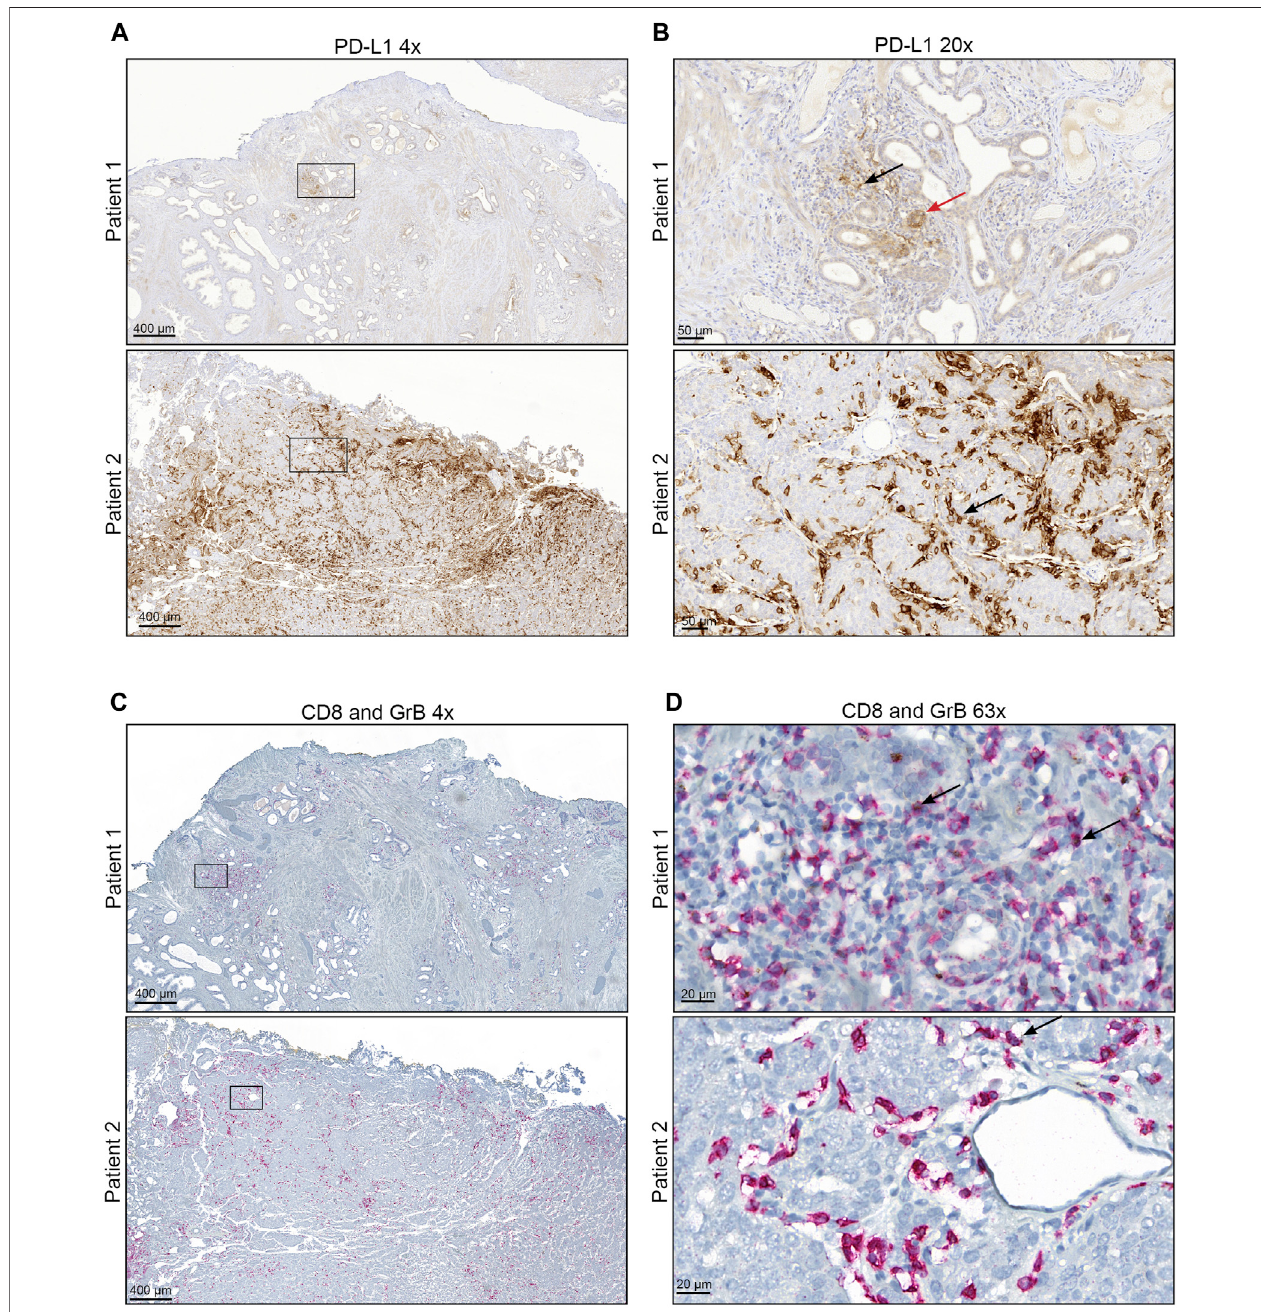
FIGURE 1 | Representative staining of PD-L1, CD8 + , and GrB (A + B) Immunohistochemical staining for PD-L1 of representative PCa areas obtained with (A) ×4 objective(Scalebar=400 µM)and (B) ×20objective(Scalebar=50 µM).TheredarrowmarkrepresentsPD-L1positivetumourcells.Blackarrowsmarkrepresentative PD-L1 positive in fi ltrating immune cells. (C + D) Immunohistochemical staining for CD8 and Granzyme B of representative PCa areas was obtained with (A) ×4 objective (Scale bar = 400 µM) and (B) ×63 objective (Scale bar = 20 µM). CD8 is represented by red staining and Granzyme B by brown staining. Black arrows mark representative CD8 and Granzyme B positive in fi ltrating immune